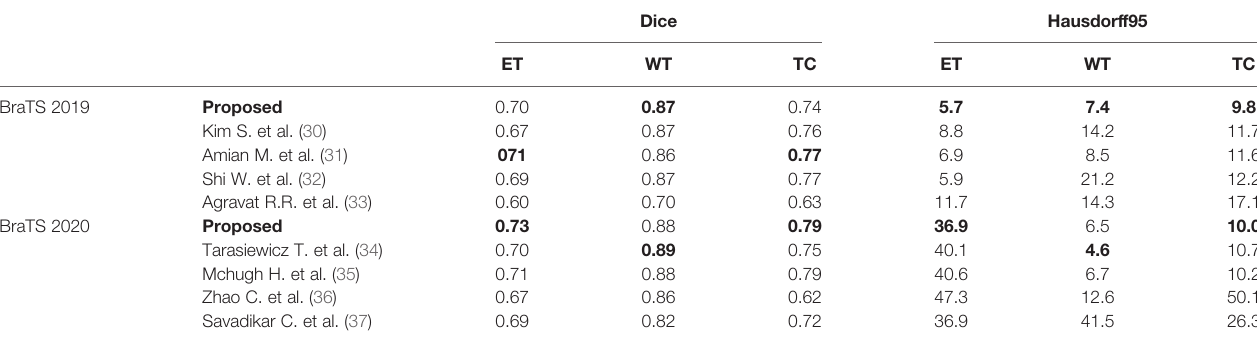
The bold values provided mean the best performed method.